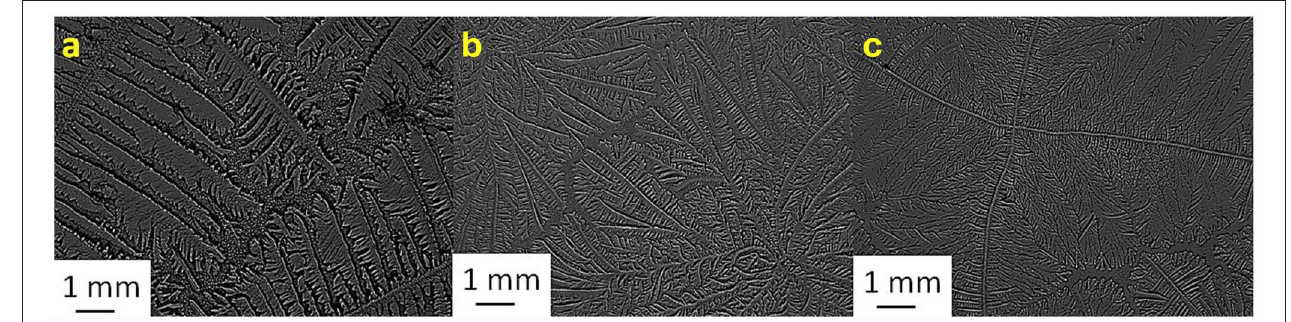
FIGURE 7 | Tear ferning patterns of (a) S7, (b) S7:KCl (1:2), and (c) S7:CaCl 2 (1:4). S7, seventh sheep tear sample.